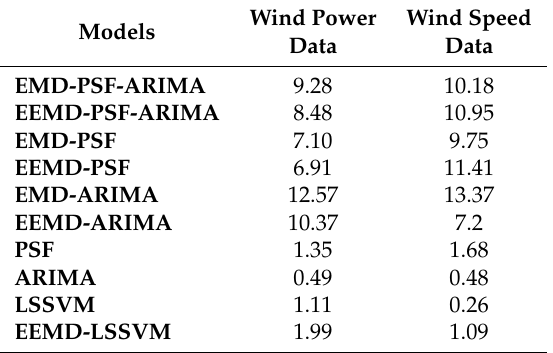
Table 5. Comparison of computation time (in